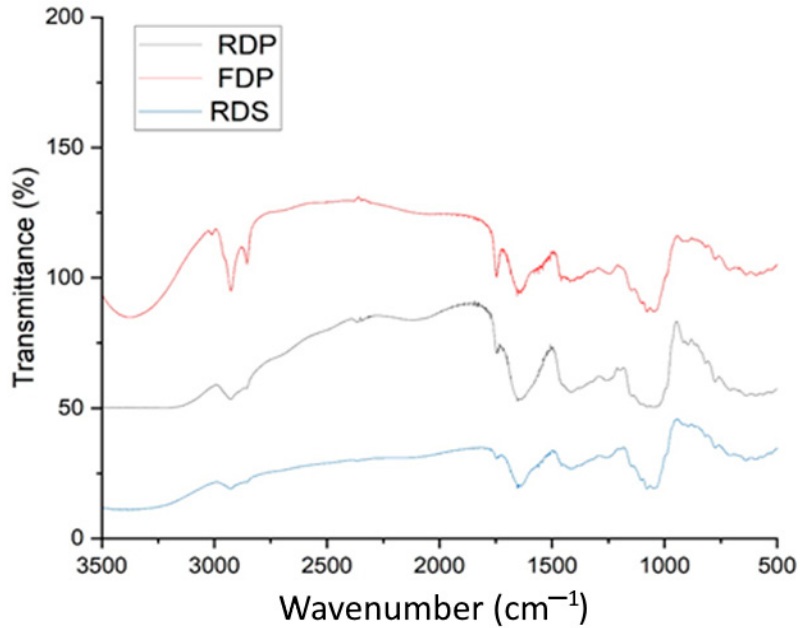
Figure 5. FTIR analysis of dragon fruit samples. For sample codes, please refer to Figure 2.